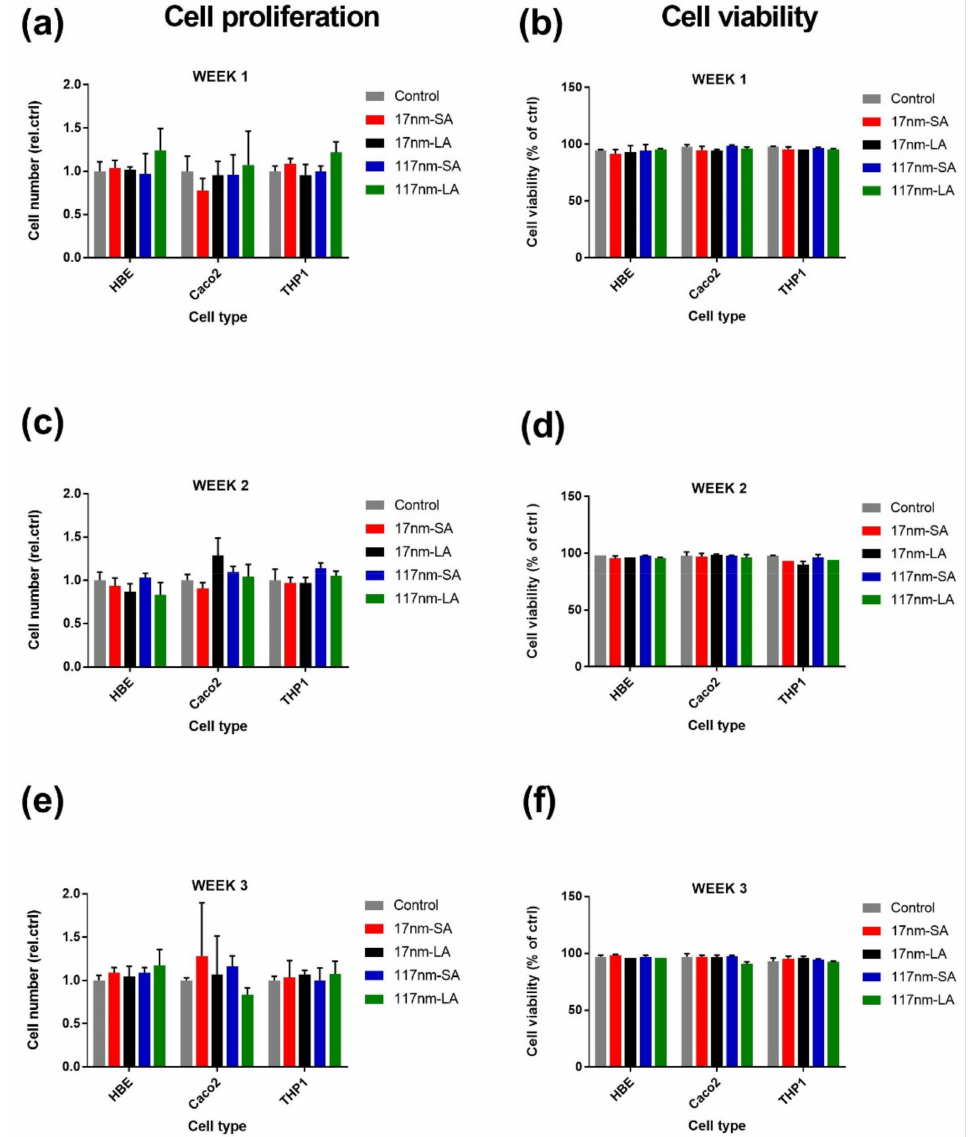
Figure 1. Effect of repeated low dose exposure to TiO 2 suspensions on cell proliferation and viability. Cell proliferation profiles ( a , c , e ) and cell viability ( b , d , f ) was measured in different cell cultures after first ( a , b ), second ( c , d ), and third exposure cycle ( e , f ). Data are expressed as means ± SD from two in- dependent experiments performed in duplicates. SA—small agglomerates; LA—large